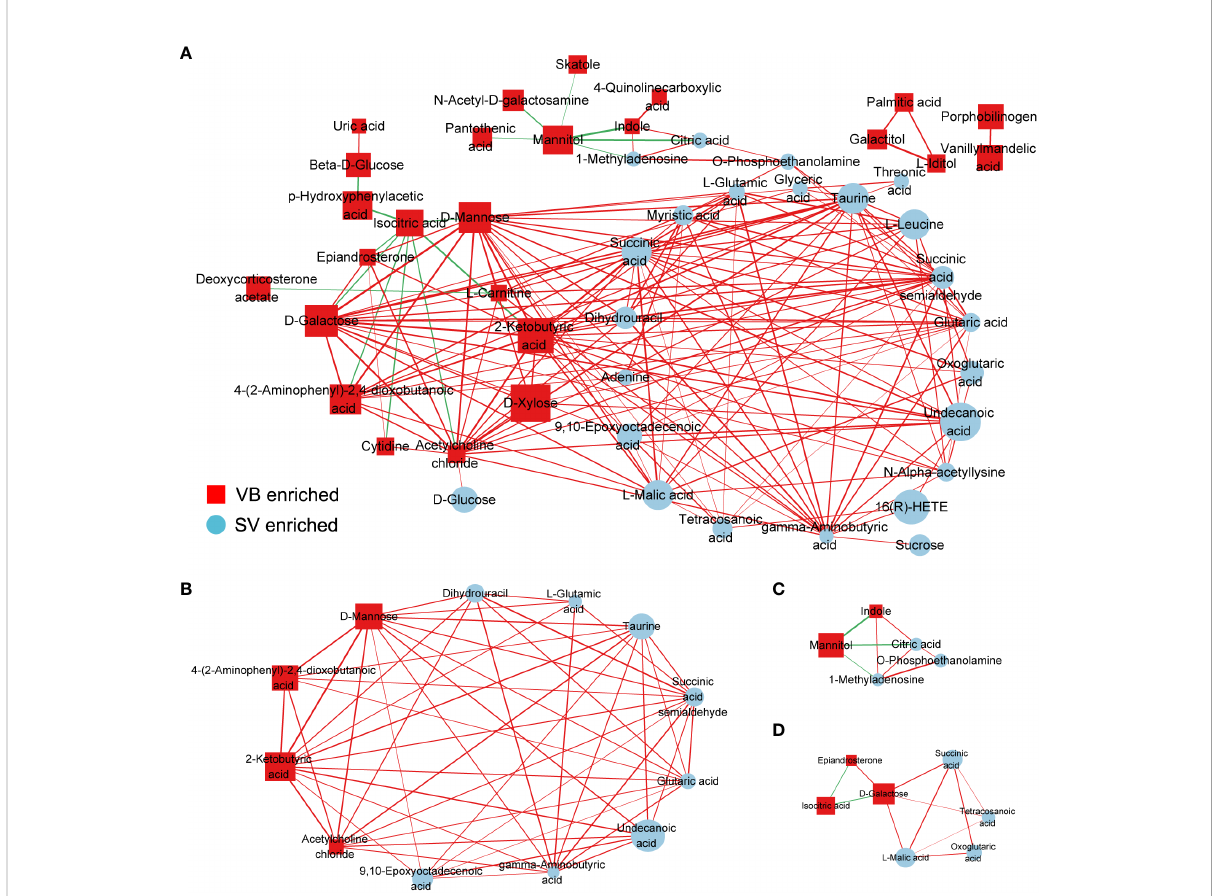
FIGURE 3 Correlation coef fi cients-based network constructed by distinct metabolites between the VB and SV groups. (A) The nodes were colored and shaped by different groups (ellipses represent SV group, and rectangle stands for the VB group). The color of the edge is set to red and green, which represent positive and negative correlation, respectively. The width of the edge indicates the magnitude of the correlation coef fi cient. (B – D) The three subnetworks were identi fi ed by the MCODE plugin in the Cytoscape